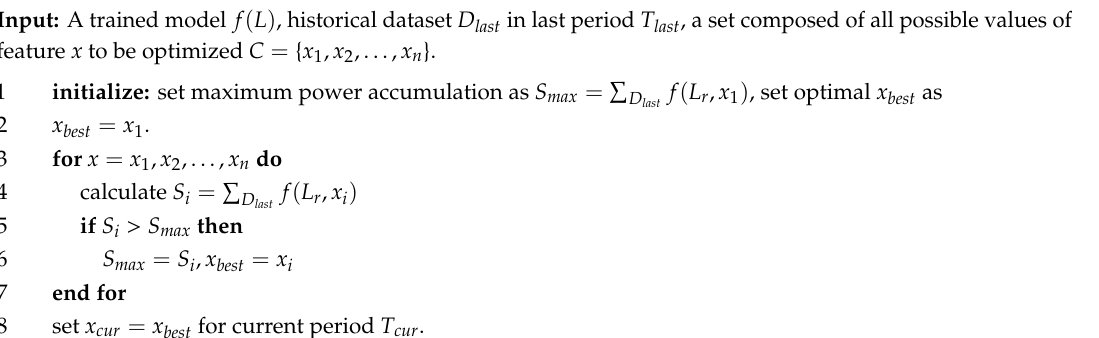
Algorithm 1: Power Optimization (Maximum Power Output Tracking)